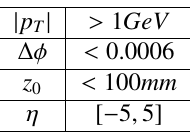
Table 1. Cuts applied to TrackML dataset for preprocessing.